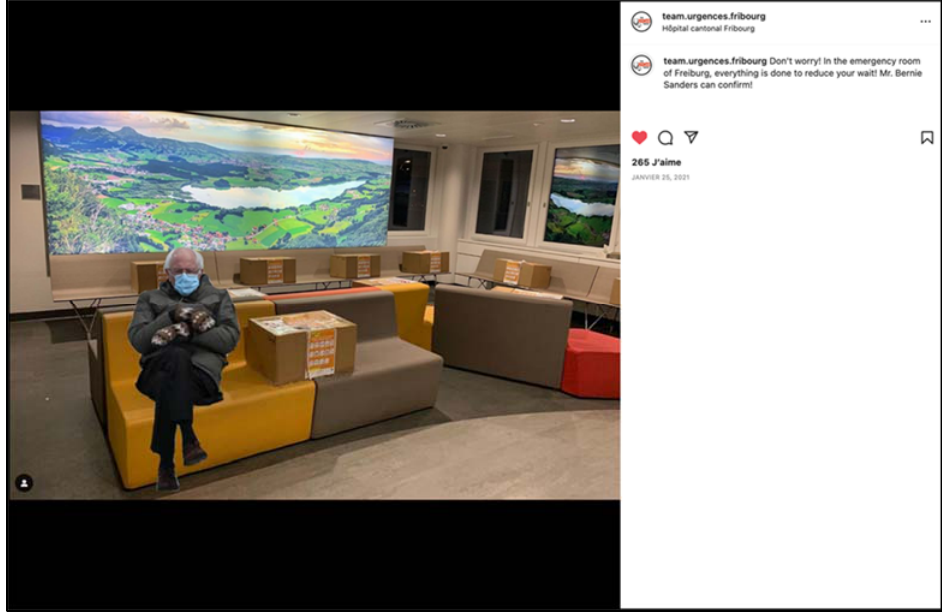
Figure 6. Use of humor to illustrate an information campaign on waiting times at the emergency room in Fribourg (screenshot using a famous image of Bernie Sanders) (screenshot).